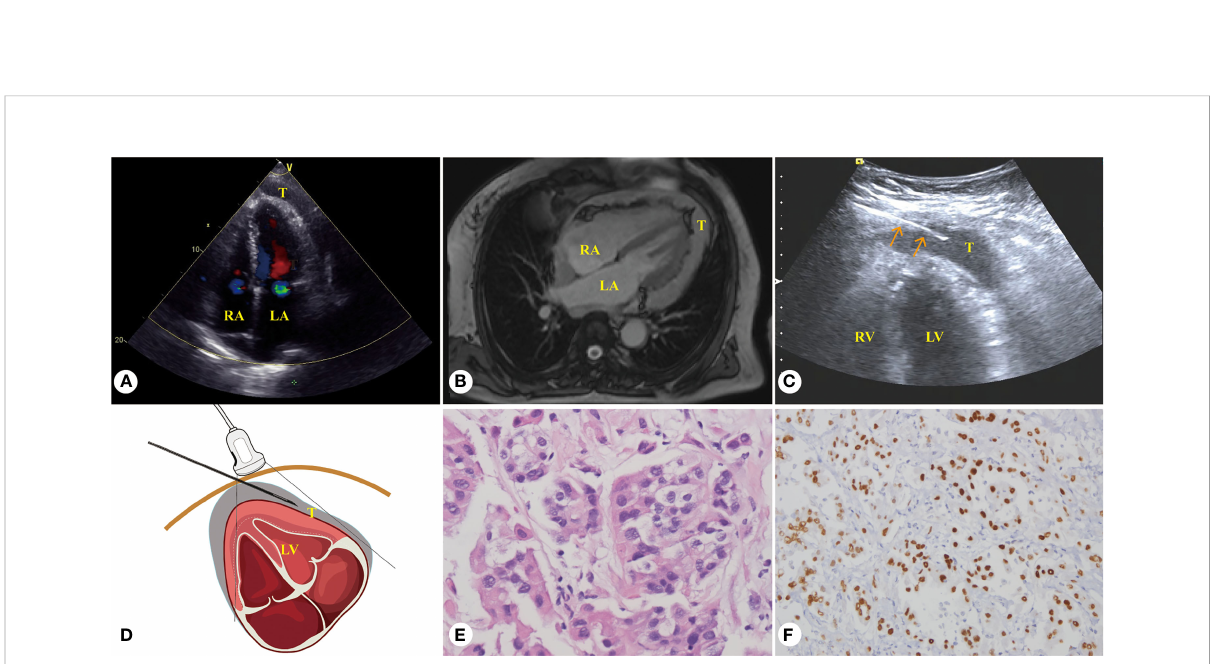
FIGURE 2 Sixty-year-old female patient, malignant mesothelioma of the pericardium. (A) Echocardiography revealed diffuse thickening lesion of the pericardium. (B) Axial conventional T2WI showed irregular diffuse long T2 signal lesions of the pericardium. (C) PUS-CNB of the apical pericardial hypoechoic lesions (red arrow shows that the biopsy needle is parallel with the myocardial wall). (D) Schematic diagram of PUS-CNB. (E) The microscopic features showed eosinophilic epithelioid cells arranged in a nested or glandular shape (H&E, × 400). (F) Immunohistochemically, the tumor cells nuclei were strongly positive for WT-1 (× 200). LA, left atrium; LV, left ventricle; RV, right ventricle; RA, right ventricle; T, tumor.